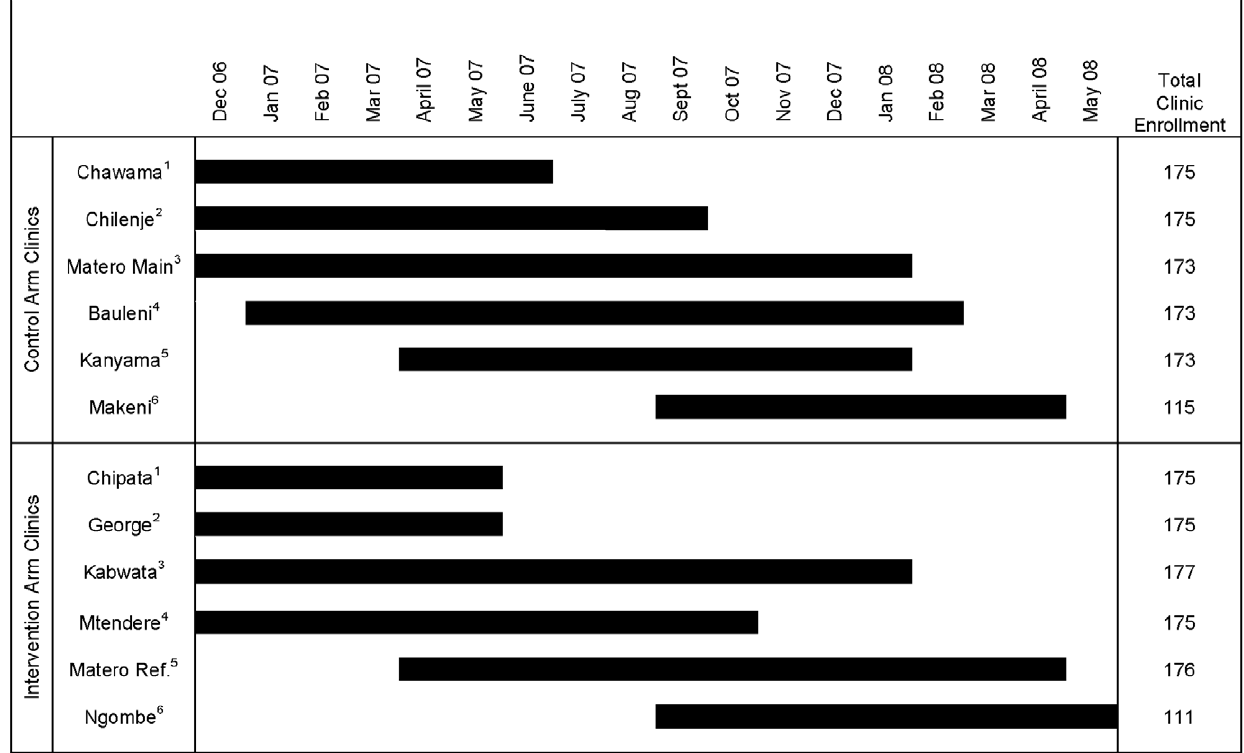
Figure 4. Participant accrual by clinic. Superscript denotes matched clinic pairs. ‘Matero Ref.’ refers to Matero Reference clinic.